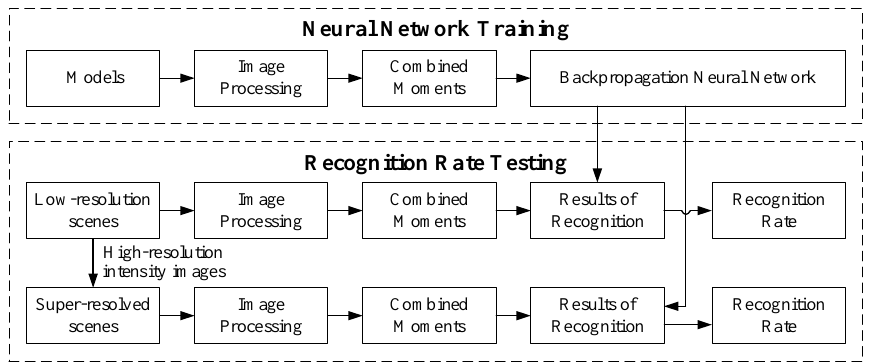
Figure 2. Block diagram for the super-resolution (SR) recognition system.